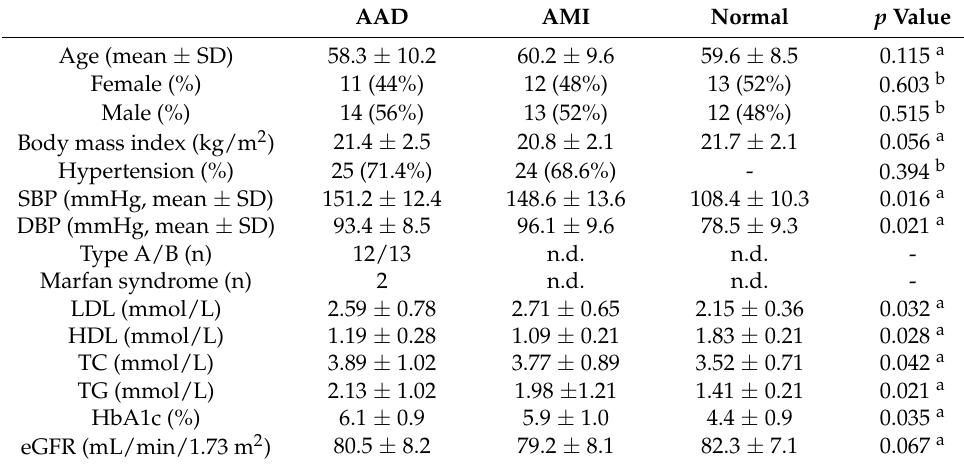
Table 1. Clinical characteristics of